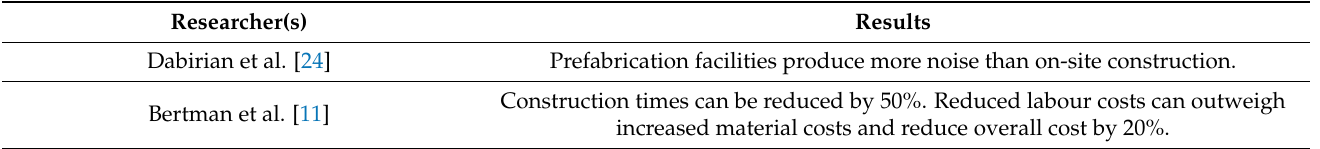
Table 1. Summary of previous literature on quantifying modular